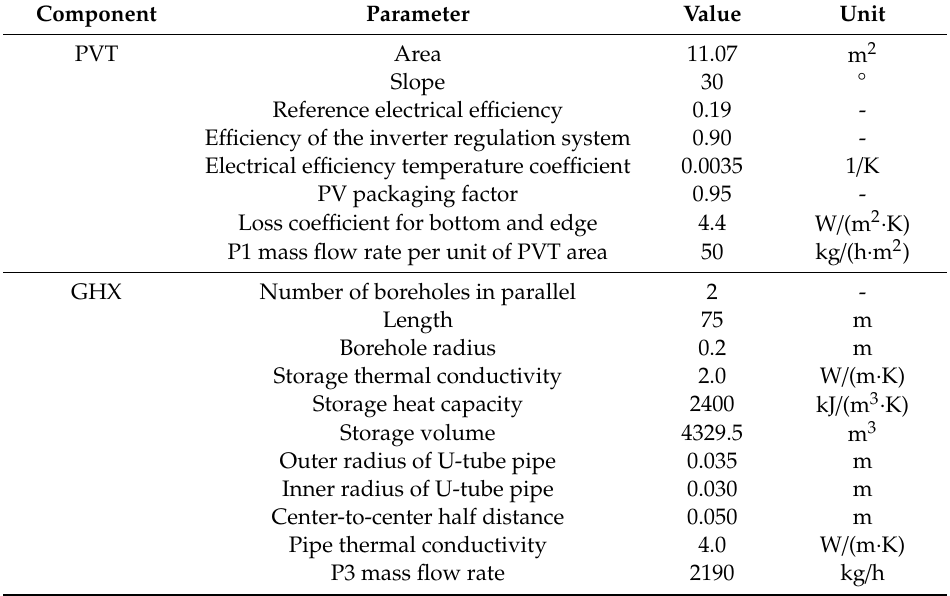
Table 3. Parameters of the main system components.